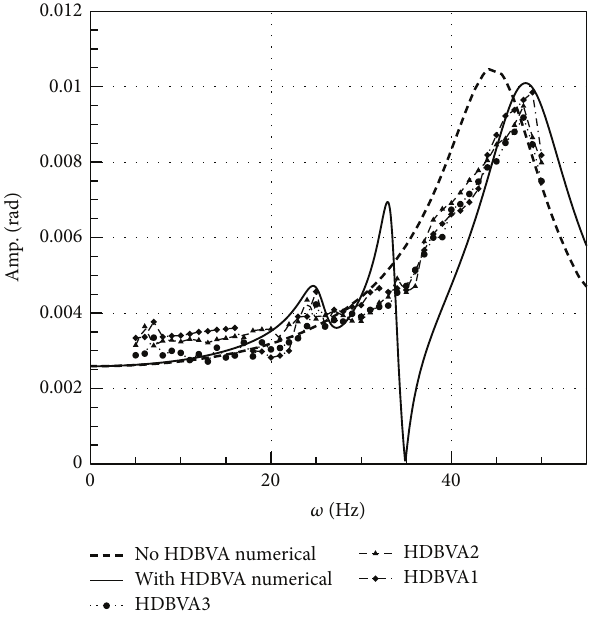
Figure 31: Frequency response of 𝑍 𝑍 DOF of case Figure 10(d), HDBVAs start at the far-from-force